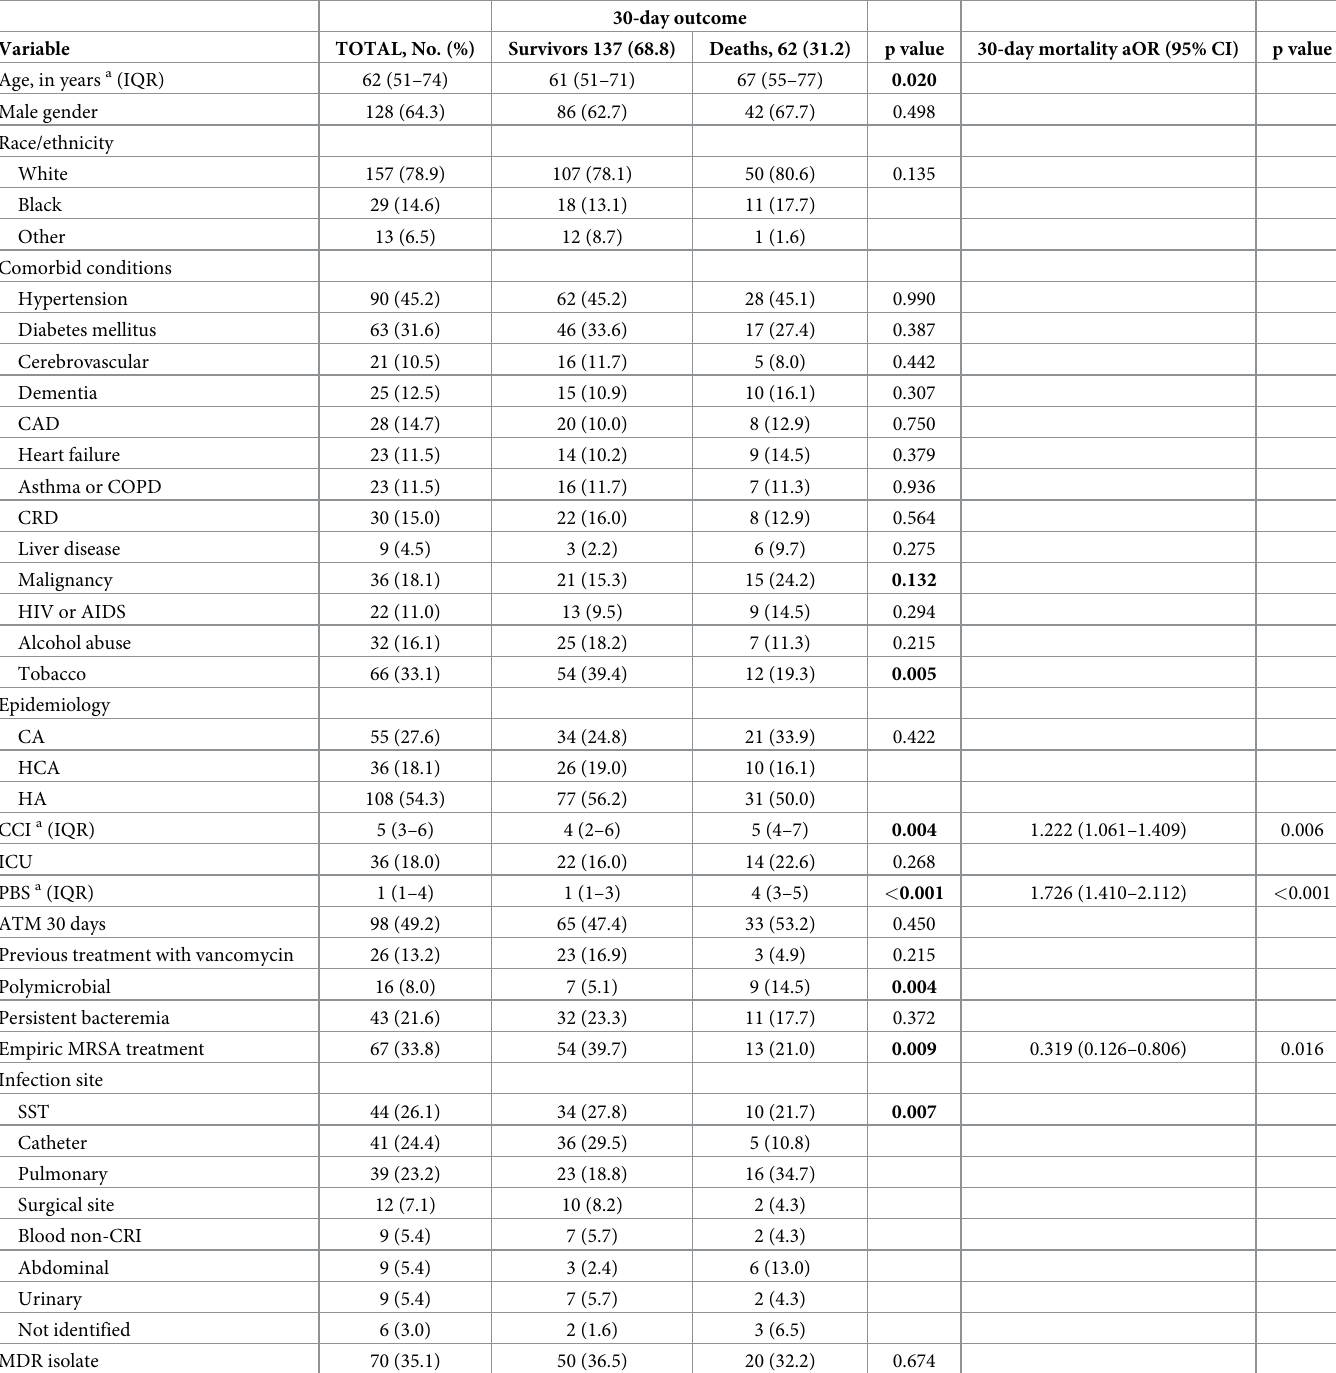
Table 1. Univariate and multivariate analysis of risk factors for 30-day all-cause mortality in patients with MRSA